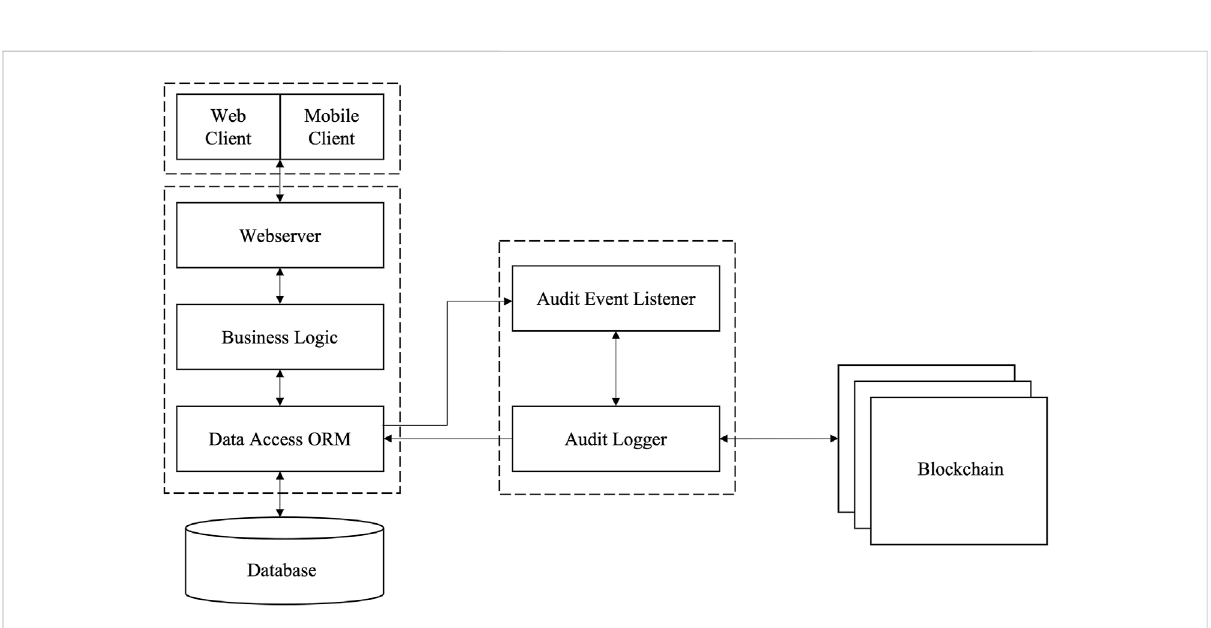
FIGURE 5 ORM model (McDonald,